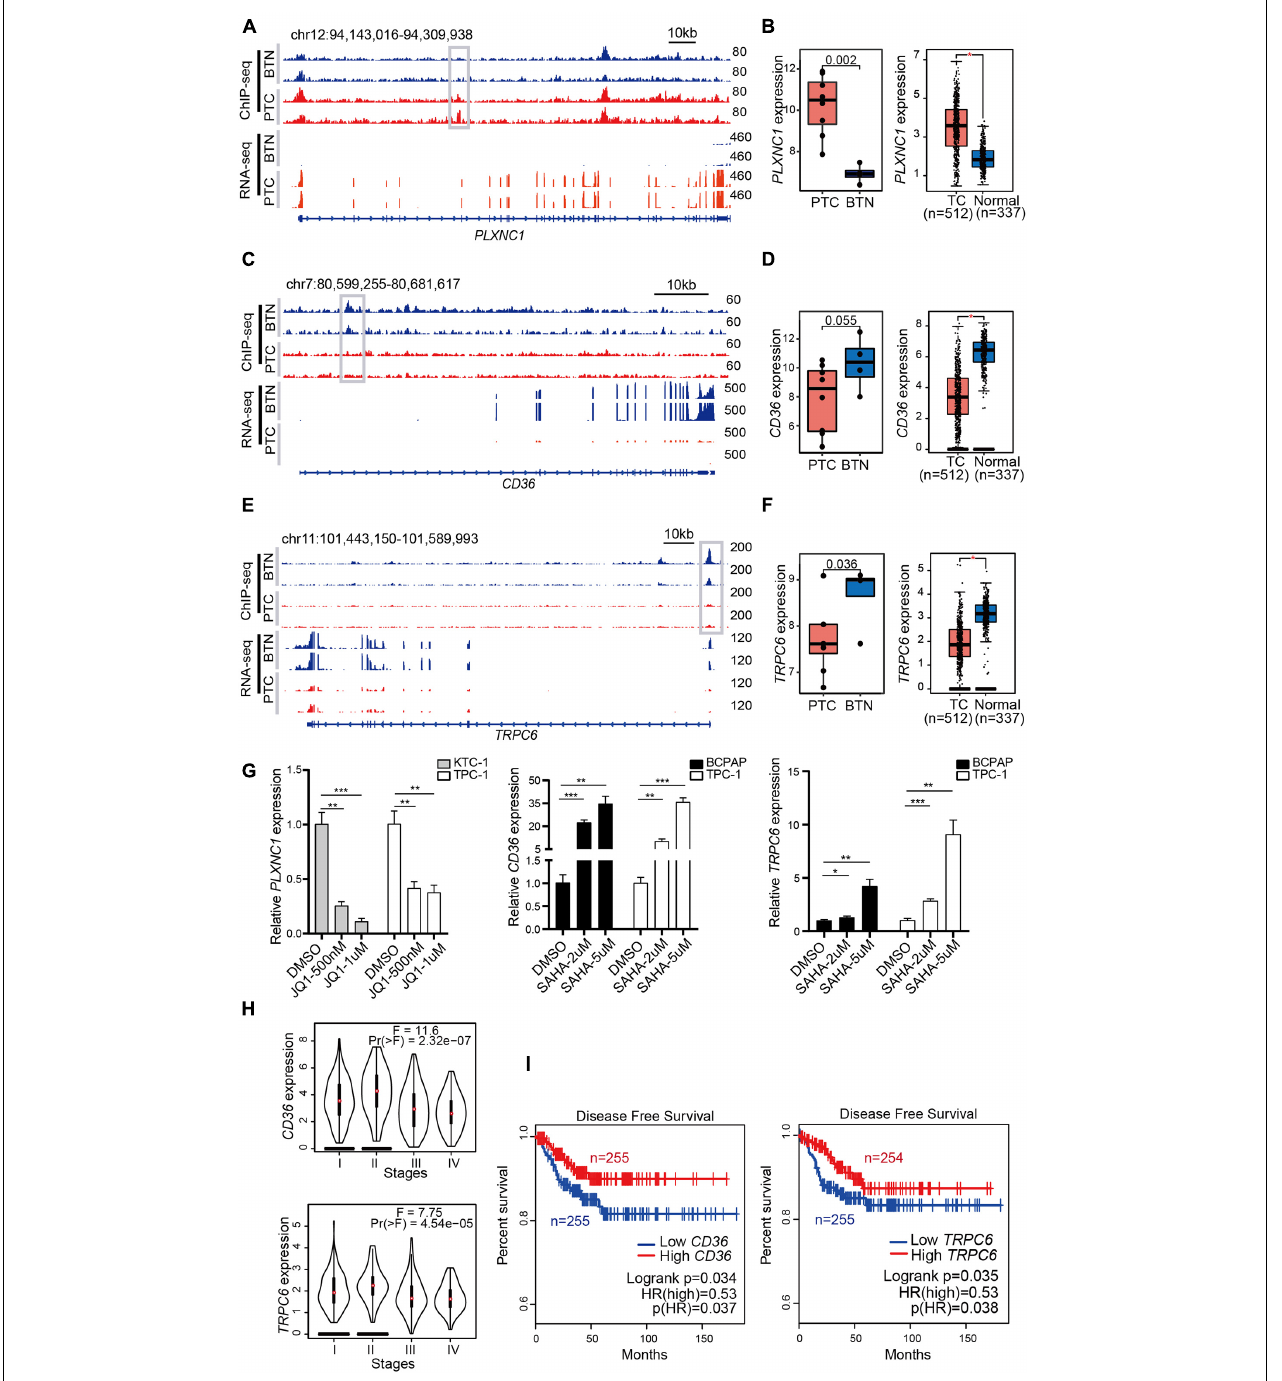
FIGURE 5 | Identification of H3K27ac modification-related genes that are sensitive to epigenetic drugs and associated with the prognosis of PTC. (A) H3K27ac ChIP-seq signals and RNA-seq tracks of PLXNC1 . (B) High expressions of PLXNC1 in PTC (left box plot), and transcriptome data from TCGA and GTEx exhibited consistent difference (right box plot). * p < 0.05. (C,E) Strong H3K27ac peaks and RNA-seq signals in CD36 and TRPC6 in BTN tissues. (D,F) Higher expressions of CD36 and TRPC6 in BTN (left box plots) and normal tissues (right box plots). * p < 0.05. (G) Treatment with JQ1 or vehicles as control at indicated concentrations for 48 h greatly reduced PLXNC1 expression levels in KTC-1 and TPC-1 cell lines. SAHA treatment induced a significant higher expression of CD36 and TRPC6 in BCPAP and TPC-1 cells. Expression analysis was normalized against GAPDH. * p < 0.05, ** p < 0.01, *** p < 0.001. (H) Lower levels of CD36 and TRPC6 transcription were observed in stage III and IV in TCGA (THCA) datasets. (I) Higher levels of CD36 and TRPC6 transcription associated with higher disease-free survival rate in patients with thyroid cancers. Analysis was performed with TCGA (THCA) datasets. PTC, papillary thyroid carcinoma; TCGA, The Cancer Genome Atlas; GTEx, Genotype-Tissue